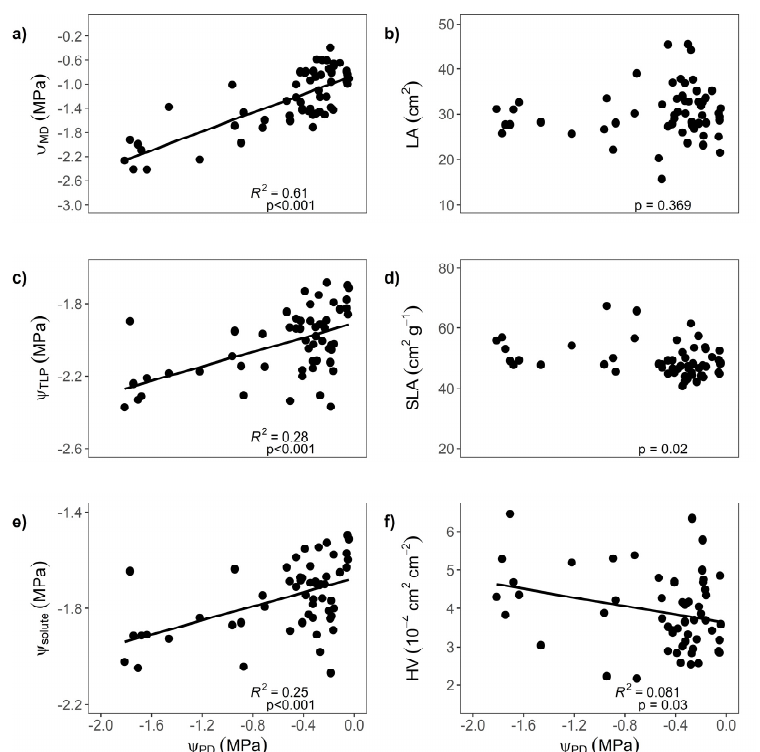
Figure 7. Relationship between pre-dawn water potential ( Ψ PD ) and ( a ) midday water potential ( Ψ MD ), ( b ) leaf area (LA), ( c ) water potential at turgor loss point ( Ψ TLP ), ( d ) specific leaf area (SLA), ( e ) solutes potential at full turgor ( Ψ solute ) and ( f ) Huber Value (HV) in Eucalyptus obliqua at the Wombat State Forest. The Ψ PD from three control plots and three impact plots (prior to the throughfall installation) was averaged to plot level for this analysis.